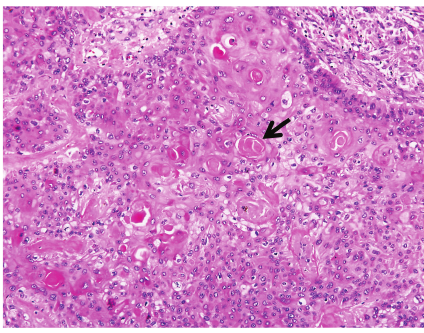
Figure 18: Proliferating tricholemmal tumor: the lesion shows proliferation of squamous cells with clear cytoplasm and abrupt pilar-type keratinization (arrow) (H&E, × 200).